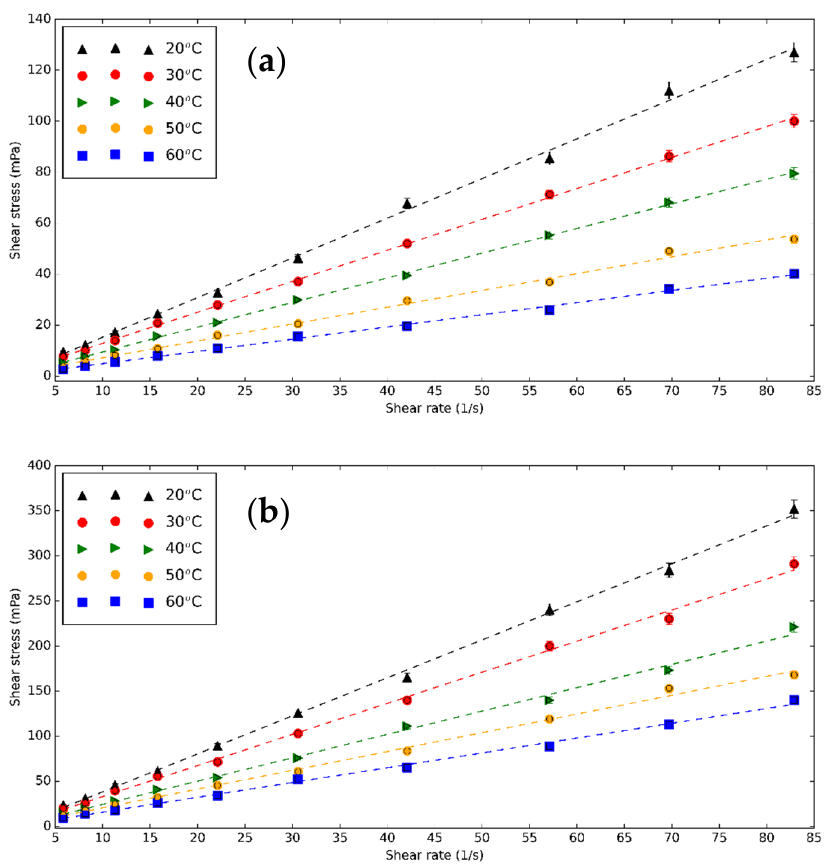
Figure 8. Shear stress—shear rates diagram of ( a ) CNS and ( b ) CNP nanofluids for 0.5 vol% at different temperatures.